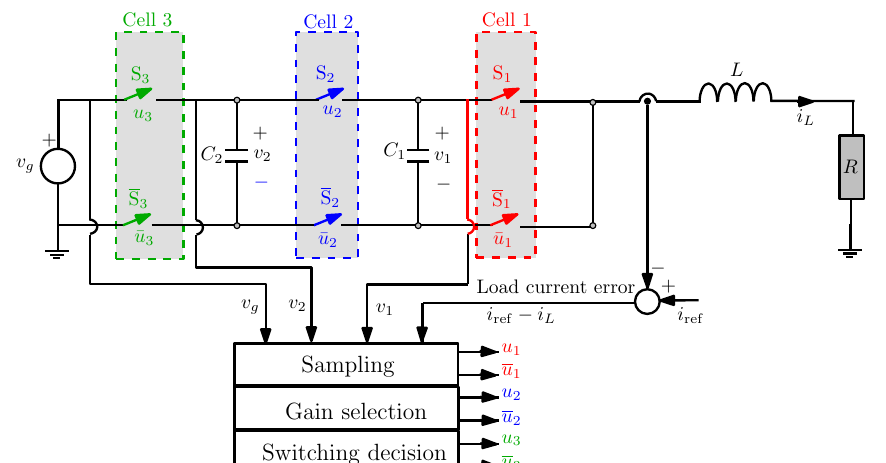
Figure 1. Topology of flying capacitor three-cell buck converter.